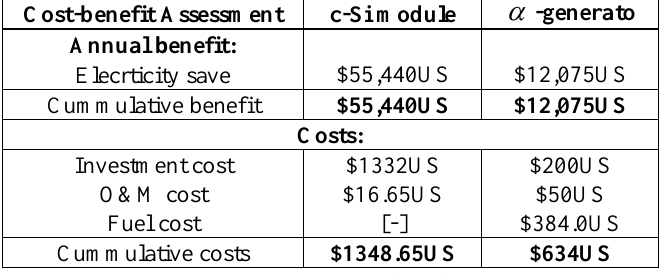
Figure 5: schematic of off-grid solar based charging systems. Source: Authors, (2022). Table 2: System specification of 650W PV charging systems and Table 3: Cost-benefit Assessment for 25 years of 650W PV Gasoline based generator. Charging Systems using c-Si PV modules at electricity cost of